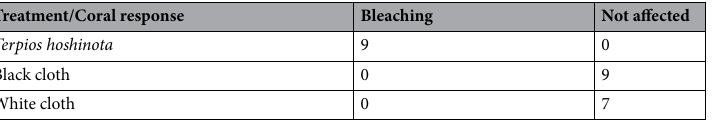
Table 1. Coral responses in the sponge fragment test. Terpios hoshinota is more likely to cause coral bleaching ( T. hoshinota vs. black cloth: p < 0.001; T. hoshinota vs. white cloth: p < 0.001, Chi-square tests).